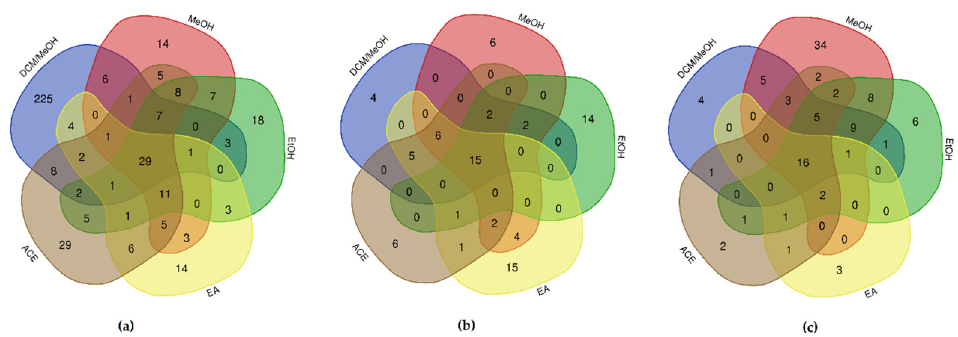
Figure 7. Venn diagrams showing overlapping and unique compounds of E. foeminea crude extracts using different solvents analyzed by ( a ) positive ion mode and ( b ) negative ion mode LC–MS scans, and ( c ) GC–MS scan. Ace, acetone; DCM/MeOH, dichloromethane/methanol; EtOH, ethanol; EA, ethyl acetate; MeOH, methanol.